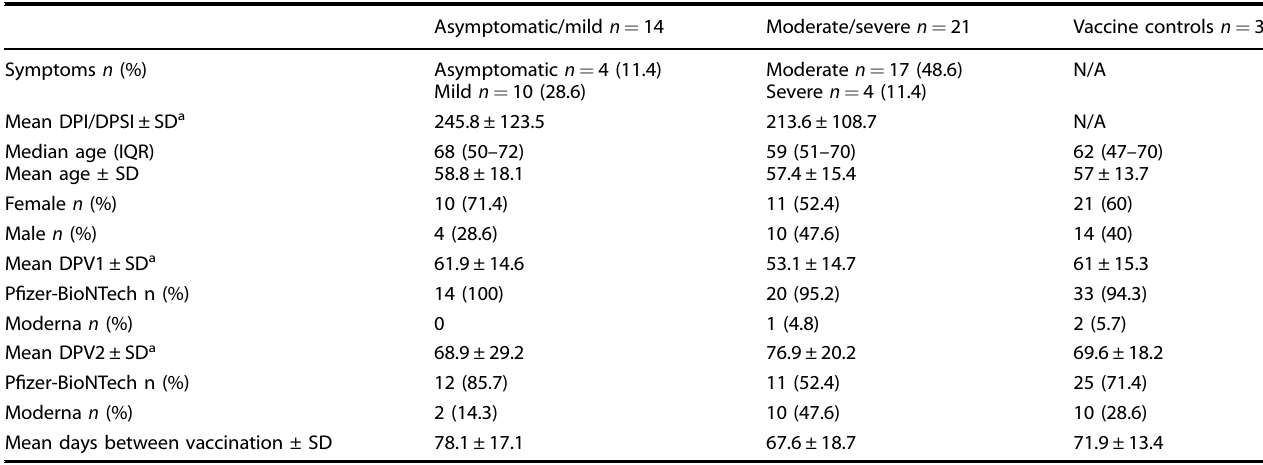
Table 1. Relevant features and categorization of study